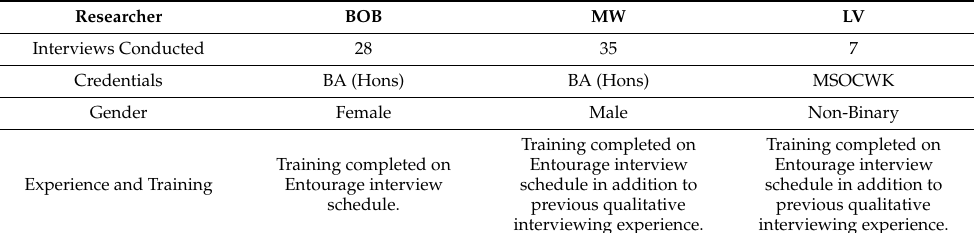
Table A2. Researcher information guided by CORE-Q guidelines [38].